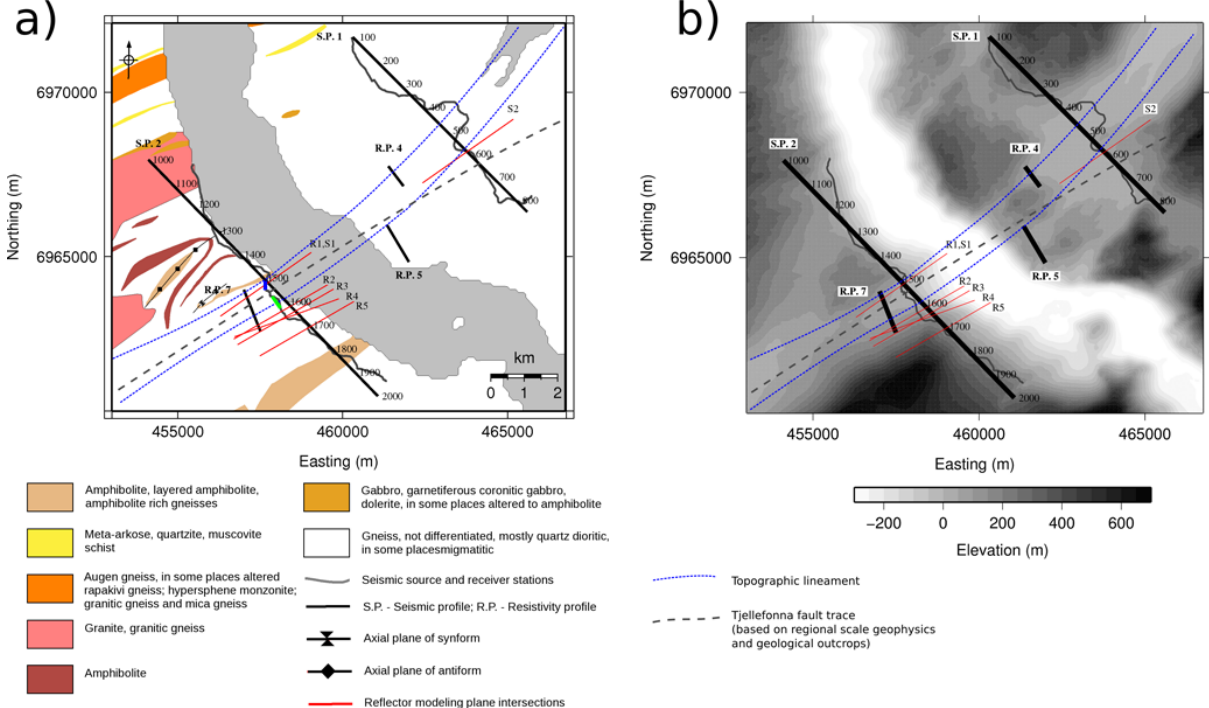
Fig. 2. (a) Simplified geological map after Tveten et al. (1998). S.P – Seismic Profile; R.P – Resistivity Profile; Green zone – LVA; Blue zone – LVB see text for explanation. (b) Topography of the study area. The topographic low is seen between the blue dashed lines on both figures. The thicker gray dashed line indicates the Tjellefonna fault trace based on geological outcrops and regional scale geophysics (Nasuti et al.,